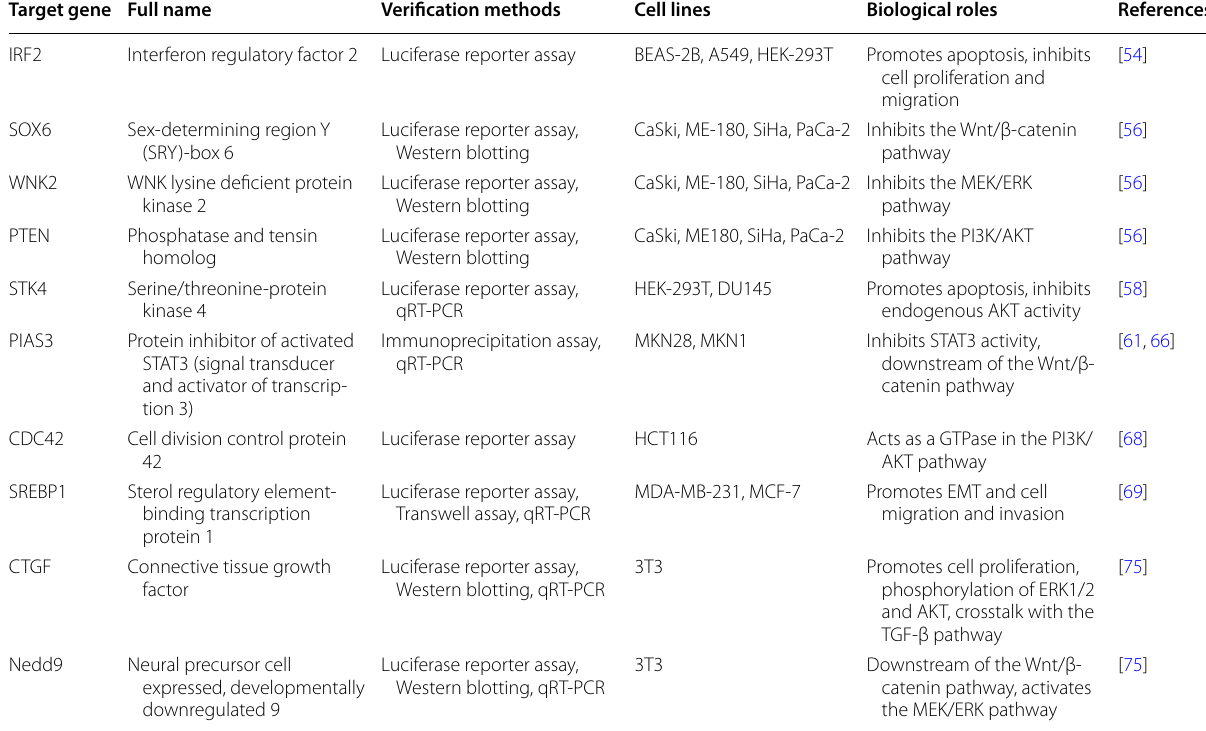
Table 1 List of experimentally validated miR-18a targets and their biological roles Target gene Full name Verification